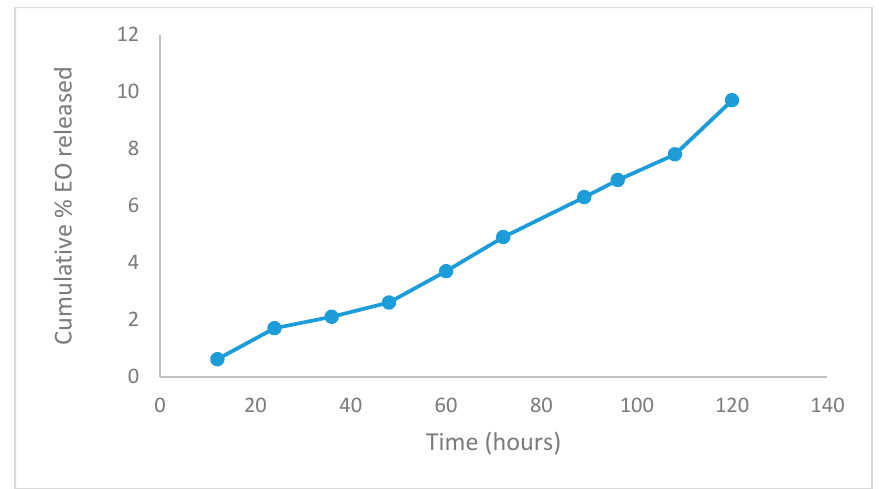
Figure 3. Cumulative EO percentage released from optimized capsules in a phosphate buffer (Ph 7.4).